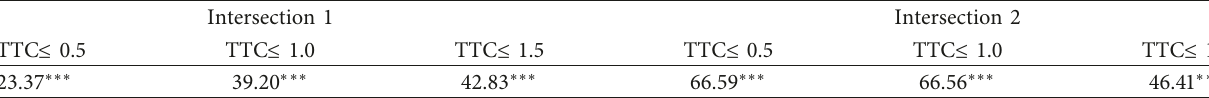
Table 2: One-way ANOVA-test result.